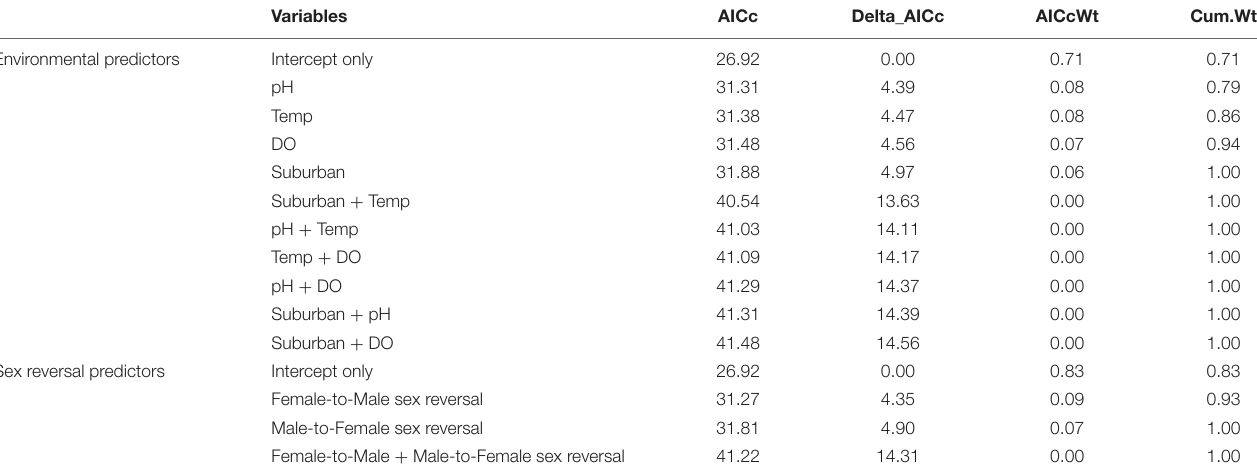
TABLE 2 | Models of phenotypic sex ratios as a function of environment and sex reversal.